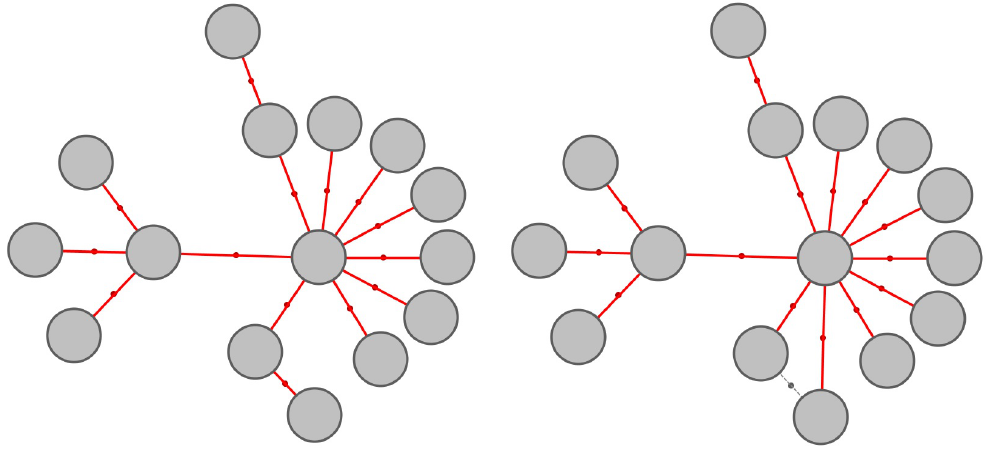
Figure 5: The resulted spanning trees from the original algorithm (left) and the modified algorithm (right)